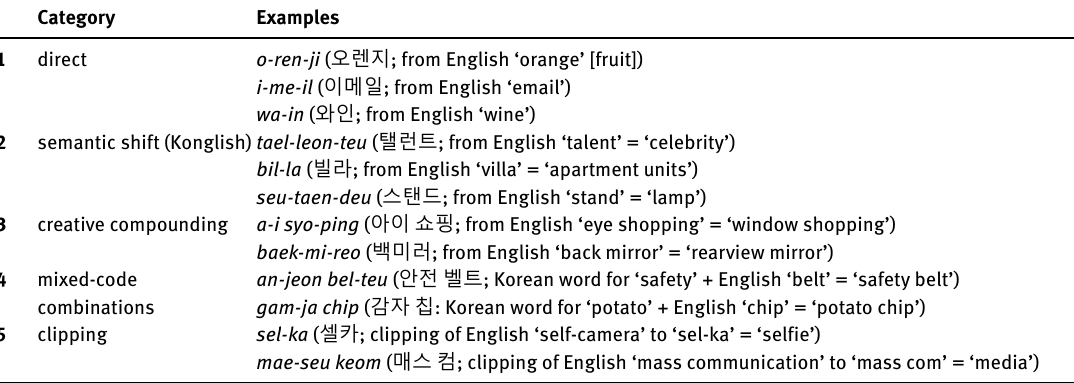
Table 1. English Loanword Categories and Examples (Based on Kim